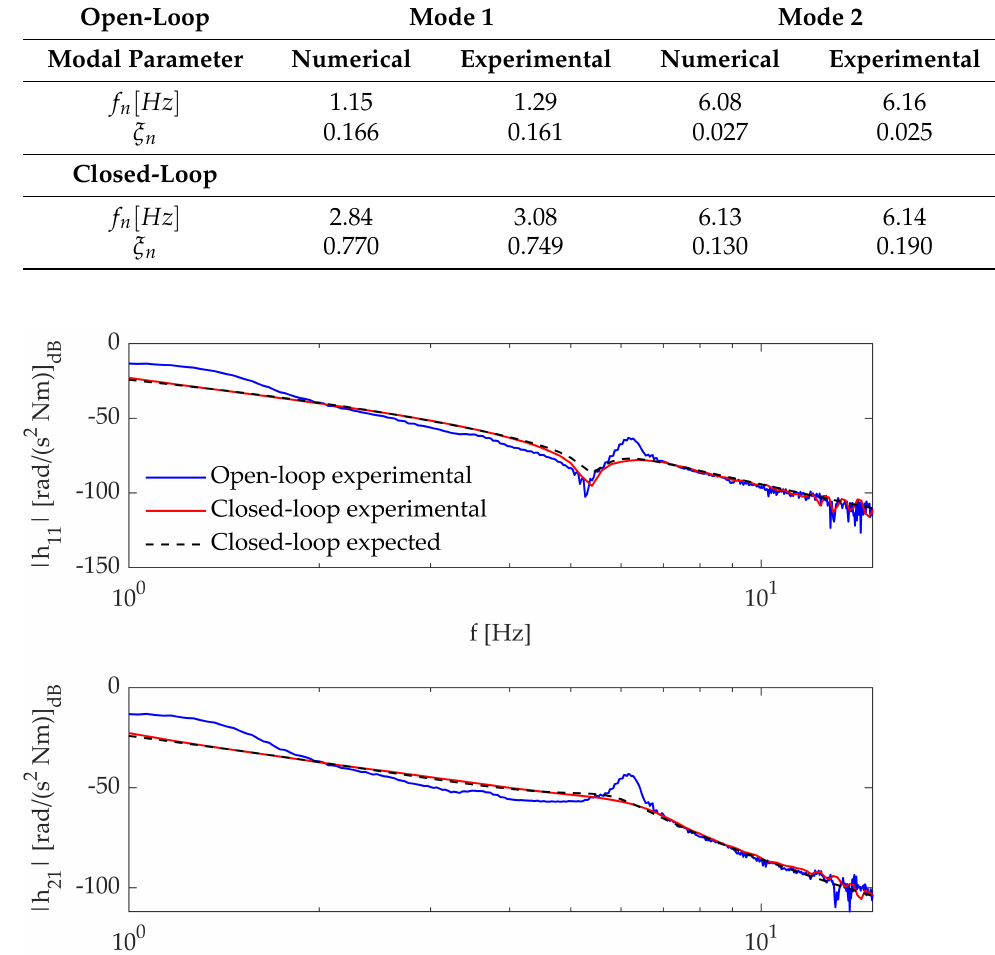
Table 4. Test case 1: numerical and experimental modal parameters.